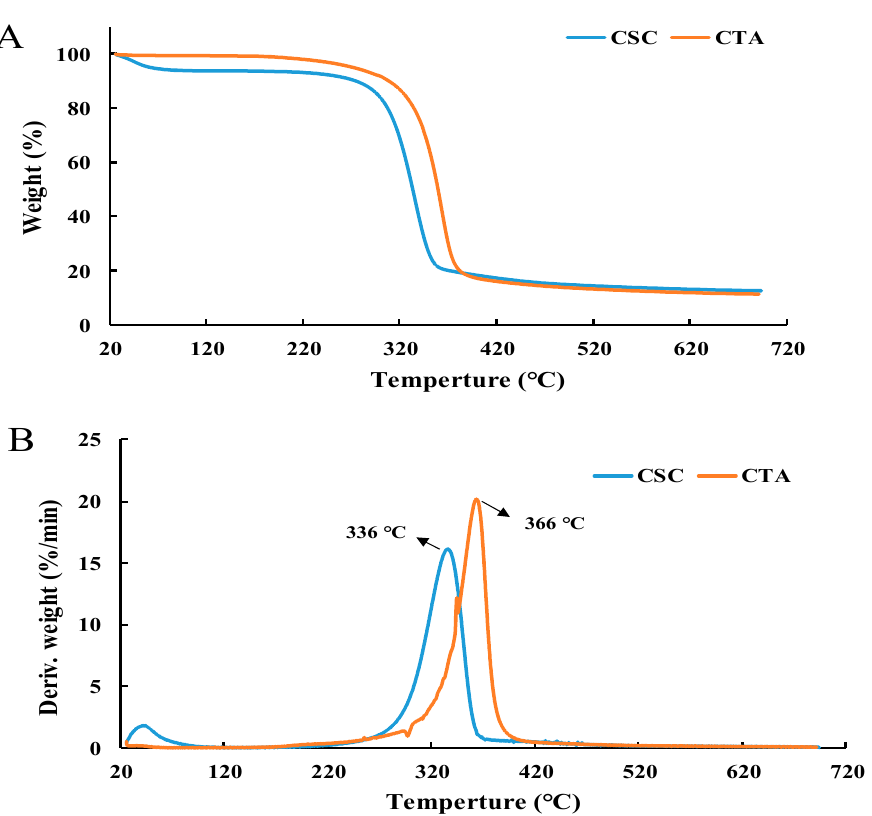
Figure 5. TGA ( A ) and DTG ( B ) curves of CSC and CTA. Table 2. Thermogravimetric results for corn stover cellulose (CSC) and cellulose triacetate (CTA).